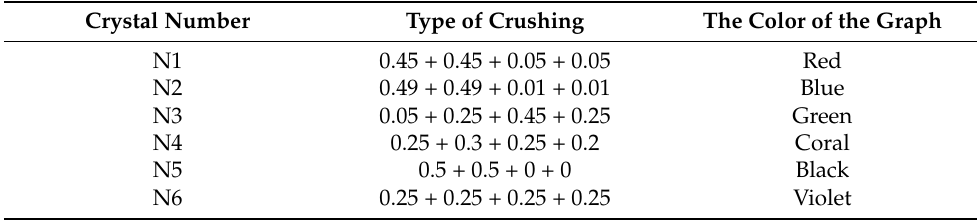
Figure 8. Change in the phase acoustic velocity during crushing of the components of a monodisperse crystal N5 with a constant concentration of the form 0.5 + 0.5 + 0 + 0. Here: N1: 0.45 + 0.45 + 0.05 + 0.05, red; N2: 0.49 + 0.49 + 0.01 + 0.01, blue; N3: 0.05 + 0.25 + 0.45 + 0.25, green; N4: 0.25 + 0.3 + 0.25 + 0.2, coral; N5: 0.25 + 0.3 + 0.25 + 0.2, black; N6: 0.25 + 0.25 + 0.25 + 0.25, violet. Table 3. Crushing of a phononic crystal.